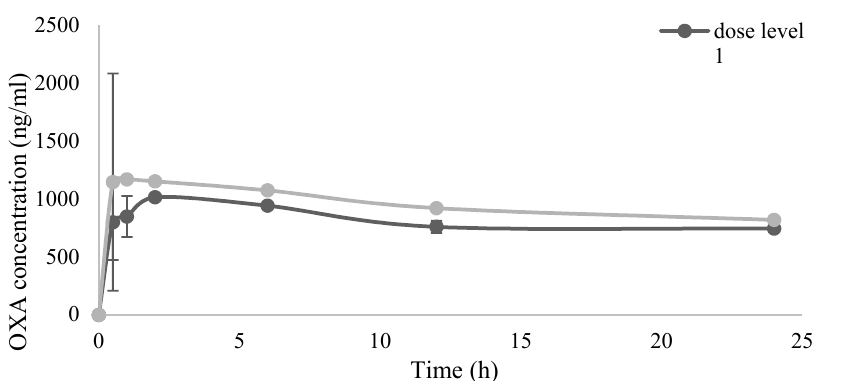
Figure 2. OXA plasma concentration (ng/mL) over time after PIPAC procedure. Results are expressed as mean ± SD.